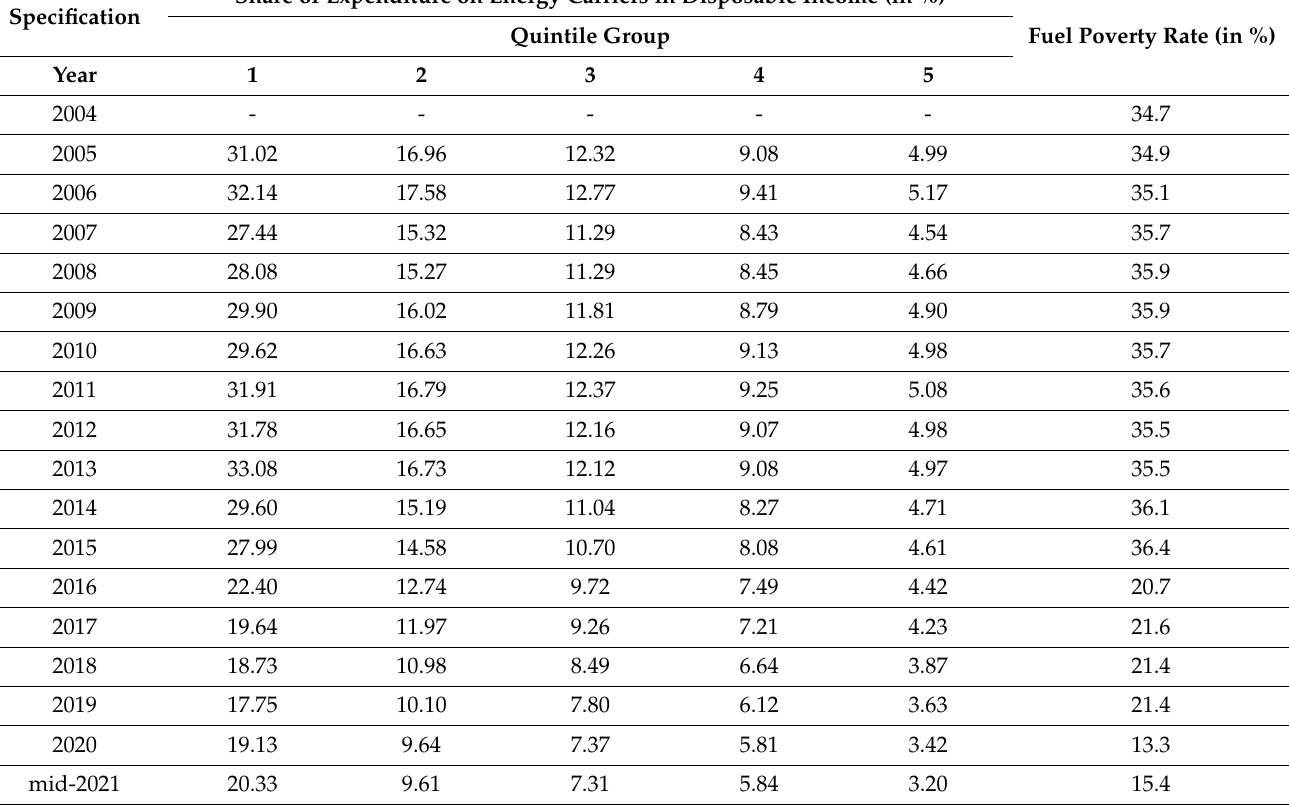
Table 1. Share of expenditure on energy carriers in disposable income per person in households by quintile groups and the fuel poverty rate in Poland in